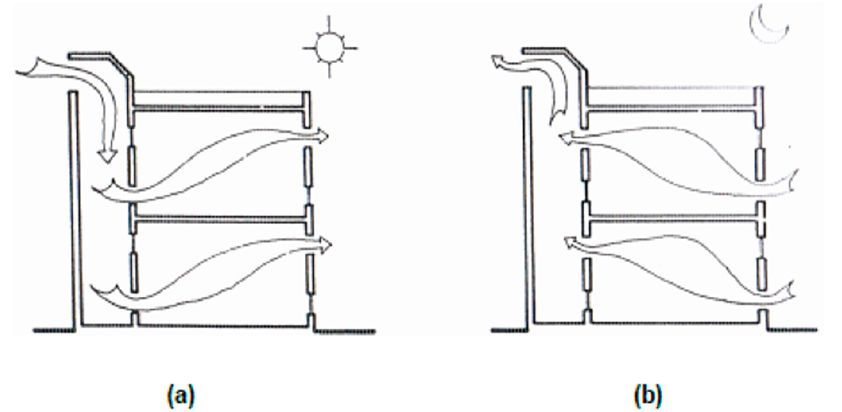
Figure 1. Wind tower system principles: ( a ) daytime down-draught operating principles and ( b ) night-time up-draught reverse-up [26].